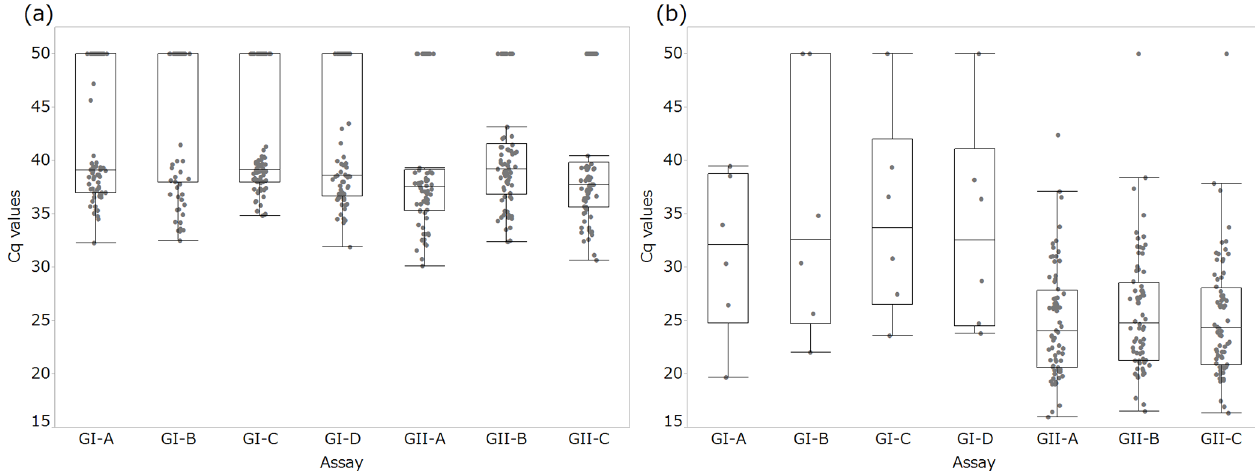
Fig 1. Distribution and box-and-whisker plots of Cq values from qPCR targeting the norovirus GI and GII. The assays were conducted with (a) wastewater samples and (b) stool samples. The box indicates the median and the quartiles. The whiskers are drawn to the furthest points within the 1.5-times interquartile range from the box. Plots at Cq = 45 and 50 show positive but not quantifiable samples (original Cq > 40) and negative samples, respectively.